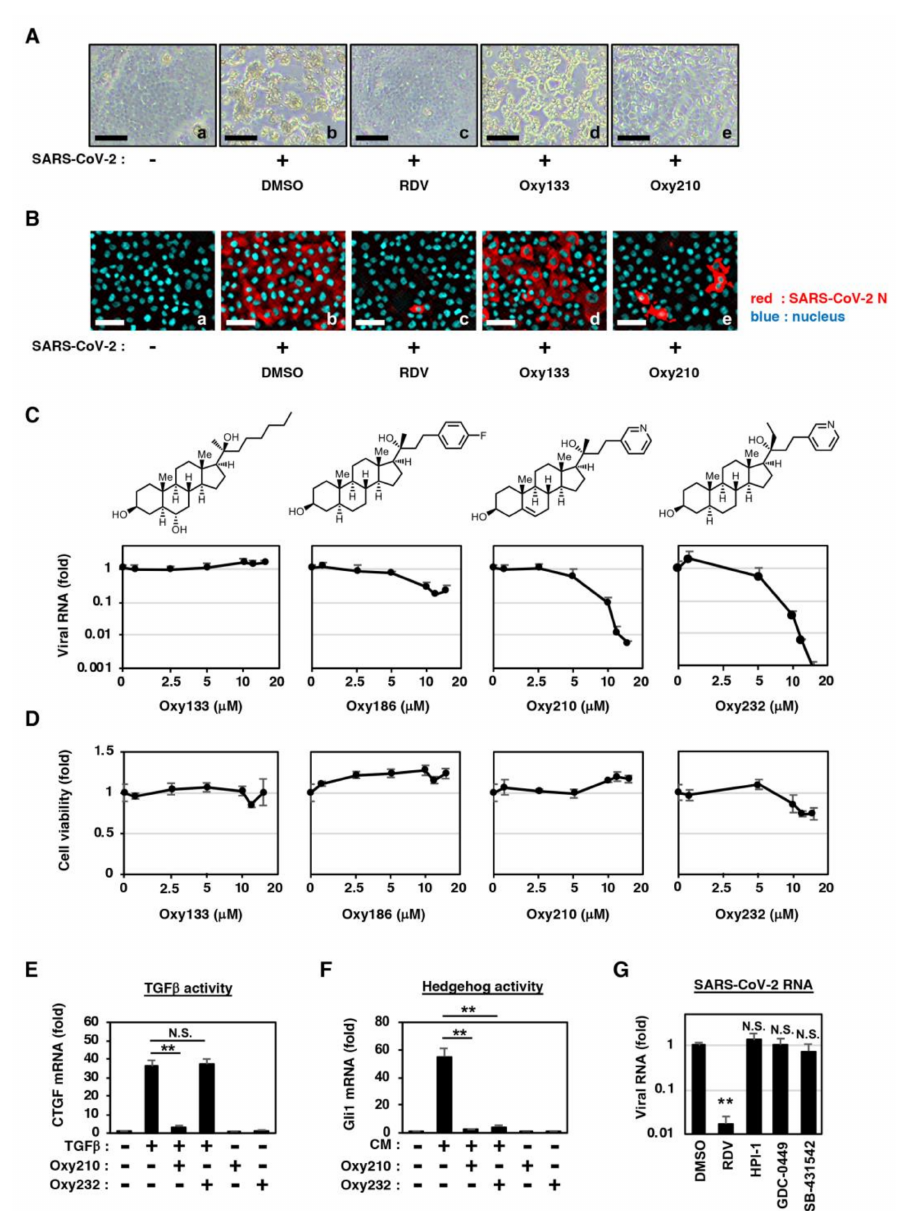
Figure 2. Oxy210, an oxysterol derivative, potently inhibits the SARS-CoV-2 propagation and alleviates the virus-induced CPE. ( A ) Virus-induced CPE was examined in the cells inoculated with the virus in the presence of DMSO, 10 µ M RDV, 10 µ M Oxy133, or 10 µ M Oxy210. Scale bar, 100 µ m. ( B ) Viral N protein in the cells was detected by immunofluorescence analysis as described in Figure 1C. Scale bar, 50 µ m. ( C ) Dose-response curves for viral RNA upon treatment with oxysterol derivatives as indicated. The secreted viral RNA in the culture supernatant at 24 h post-inoculation was quantified by real-time RT-PCR and plotted against compound concentration. The chemical structures of oxysterols are also shown above the graphs. ( D ) Viability of cells treated with the compounds was quantified using an MTT assay. ( E , F ) Inhibitory effects toward transforming growth factor β (TGF β ) and hedgehog (Hh) signaling. NIH3T3 cells pretreated with or without 10 µ M Oxy210 or 10 µ M Oxy232 for 2 h were stimulated with 20 ng/mL TGF β ( E ) or with conditioned medium (CM) from CAPAN-1 human pancreatic tumor cells that contain Shh ( F ) [15,16] in the presence or absence of the compounds at 10 µ M. Cellular mRNAs were extracted to quantify a TGF β -downstream gene, connective tissue growth factor (CTGF) ( E ), a Hh target gene, Gli1 ( F ), and Oaz1 for normalization of CTGF and Gli1 ( E , F ). ( G ) At 24 h post-inoculation, Viral RNA produced from the cells treated with DMSO, 10 µ M RDV, 10 µ M HPI-1, 10 µ M GDC-0449, or 10 µ M SB-431542, was quantified with real-time RT-PCR. All data are shown with error bars indicating S.D., ** p < 0.01 vs. DMSO; N.S., not significant, with Student’s t